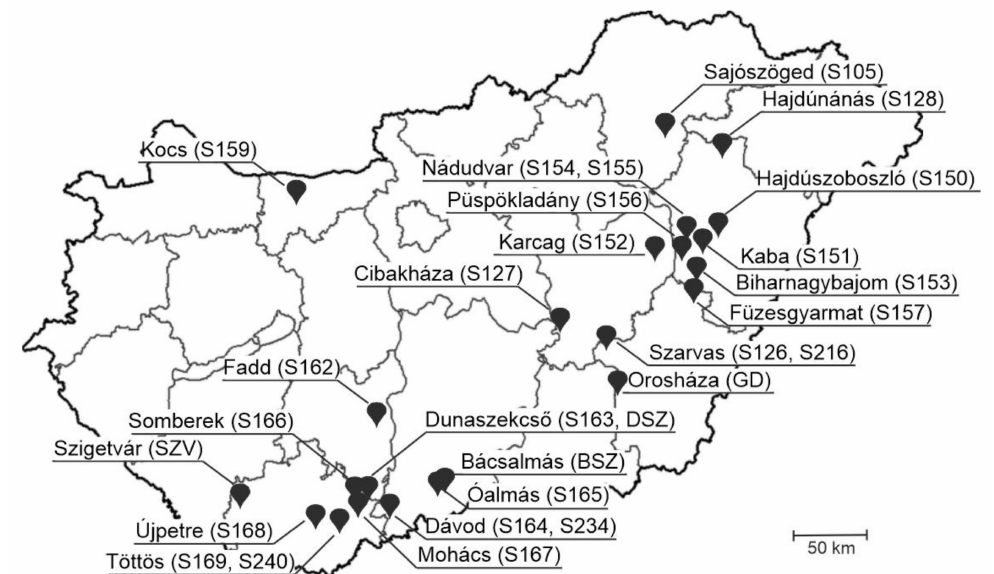
Figure 1. Localizations of n = 28 swine farms (with farm IDs) included in the investigation of the prevalence of porcine sapelovirus (PSV), porcine teschovirus (PTV) and porcine astrovirus type 3 (PoAstV-3) in n = 473 nasal swabs of 21–25-day-old asymptomatic swine by